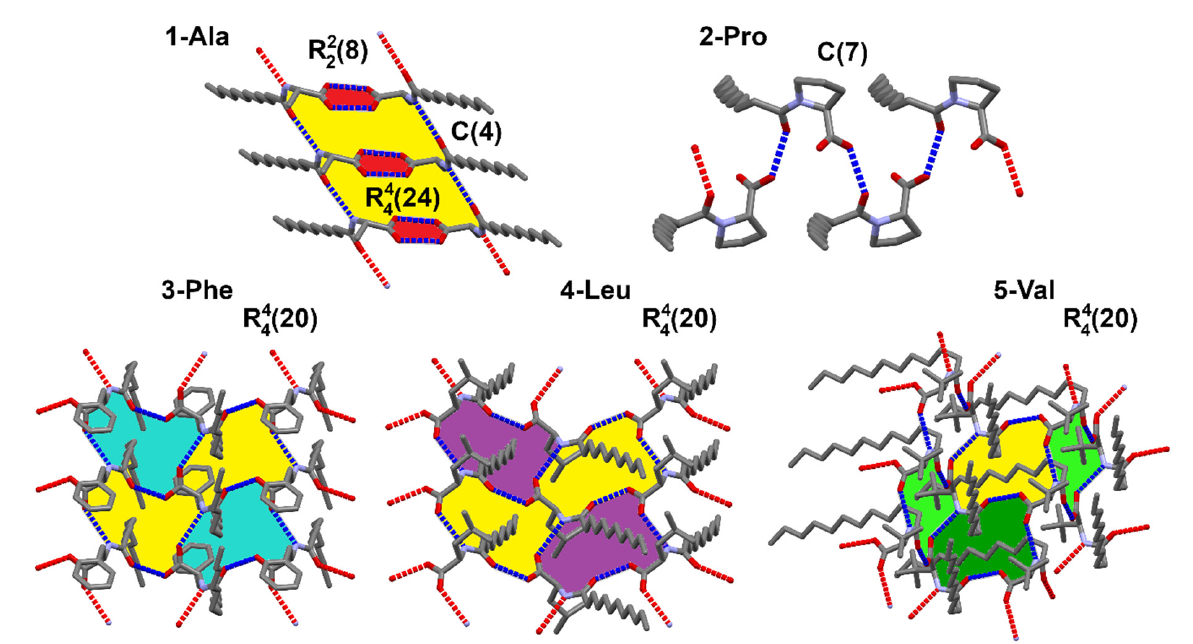
Figure 7. Supramolecular motifs according to graph set synthons notation created by strong hydrogen bonds found in the studied crystals.